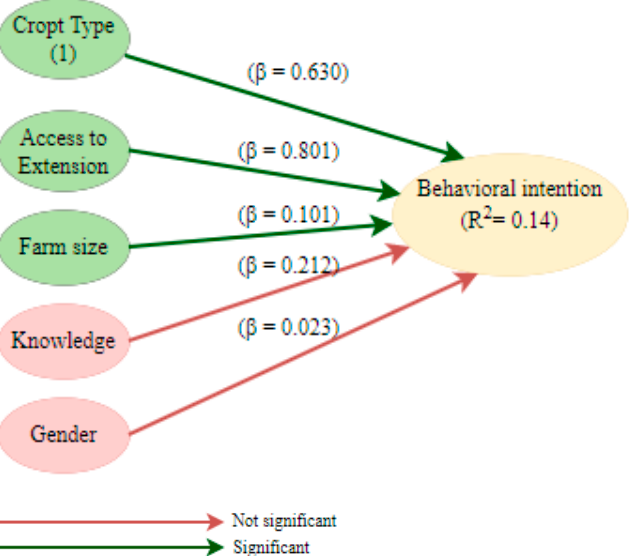
Figure 8. Predicting Behavioral intention using the sociodemographic characteristics of farmers (Model 4) . Crop Type 1 = Cowpea; R 2 = Nagelkerke R square; * p < 0.05, ** p < 0.001.